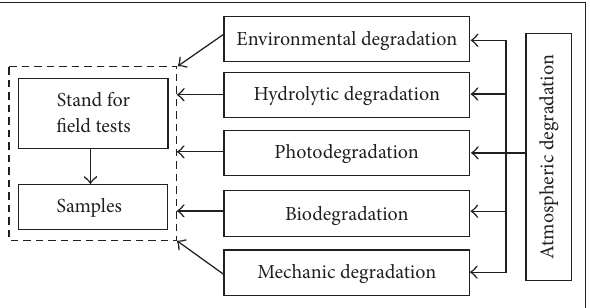
Figure 7: Scheme of natural ageing